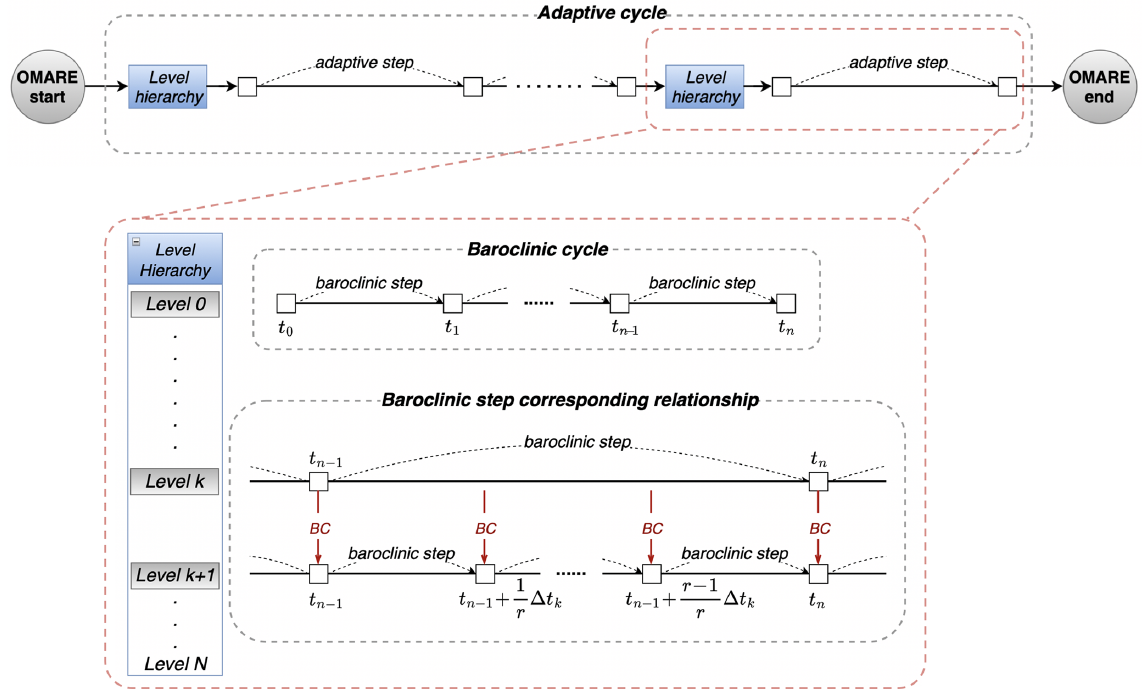
Figure 3. Flow chart of the time stepping in OMARE. The whole integration consists of many super cycles, with each super cycle consisting of several baroclinic steps on the coarsest resolution level. The grid and resolution hierarchy is (re)constructed at the beginning of an adaptive step according to the user-defined refinement criteria. The relationship between two adjacent resolution levels, k and k + 1, in the level hierarchy is shown in detail (dashed red box). The temporal refinement ratio from level k to level k + 1 is r . A single baroclinic step (from t n − 1 to t n ) of level k corresponds to r baroclinic steps of level k + 1. The time steps on the two levels are (cid:49)t k and 1 The lateral boundary conditions (BCs) are provided through online interpolations between adjacent levels.